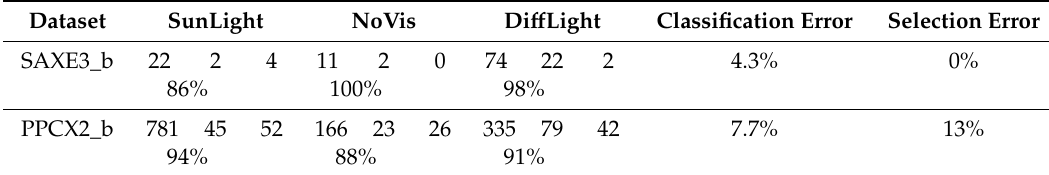
Table 5. Results of automatic classification and selection for datasets SAXE3_b and PPCX2_b. The number of images for each class are reported and correspond to exact, bivalent and erroneous classification. The percentage of correctly classified images is shown in the row below (in relation to the sum of exact and bivalent classifications). The two columns on the right show the percentage overall classification error and selection error, respectively.